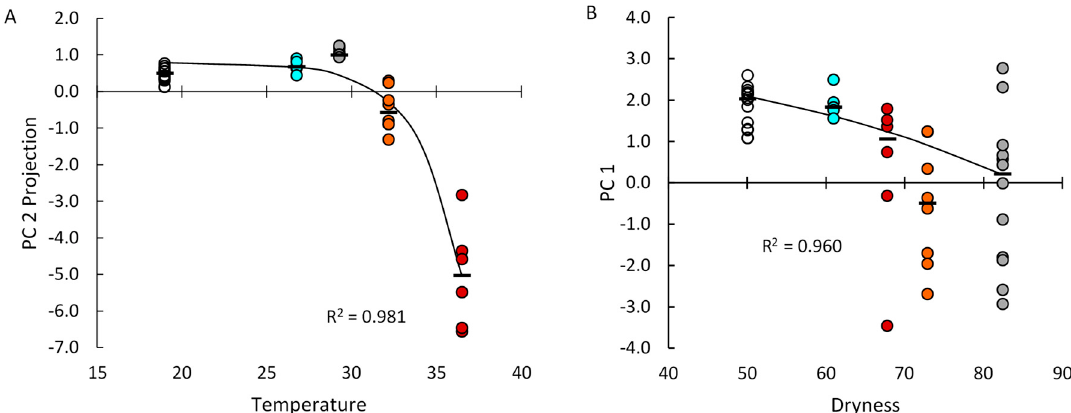
Figure 3. Relationships between median principal component projections, temperature, and dryness for glands from the nulliparous animals. ( A ) PC2 projections v mean daily high temperature; ( B ) PC1 PC 1 projections v mean daily high degree of dryness. ( − , median projections; other symbols as in Figure 3A).